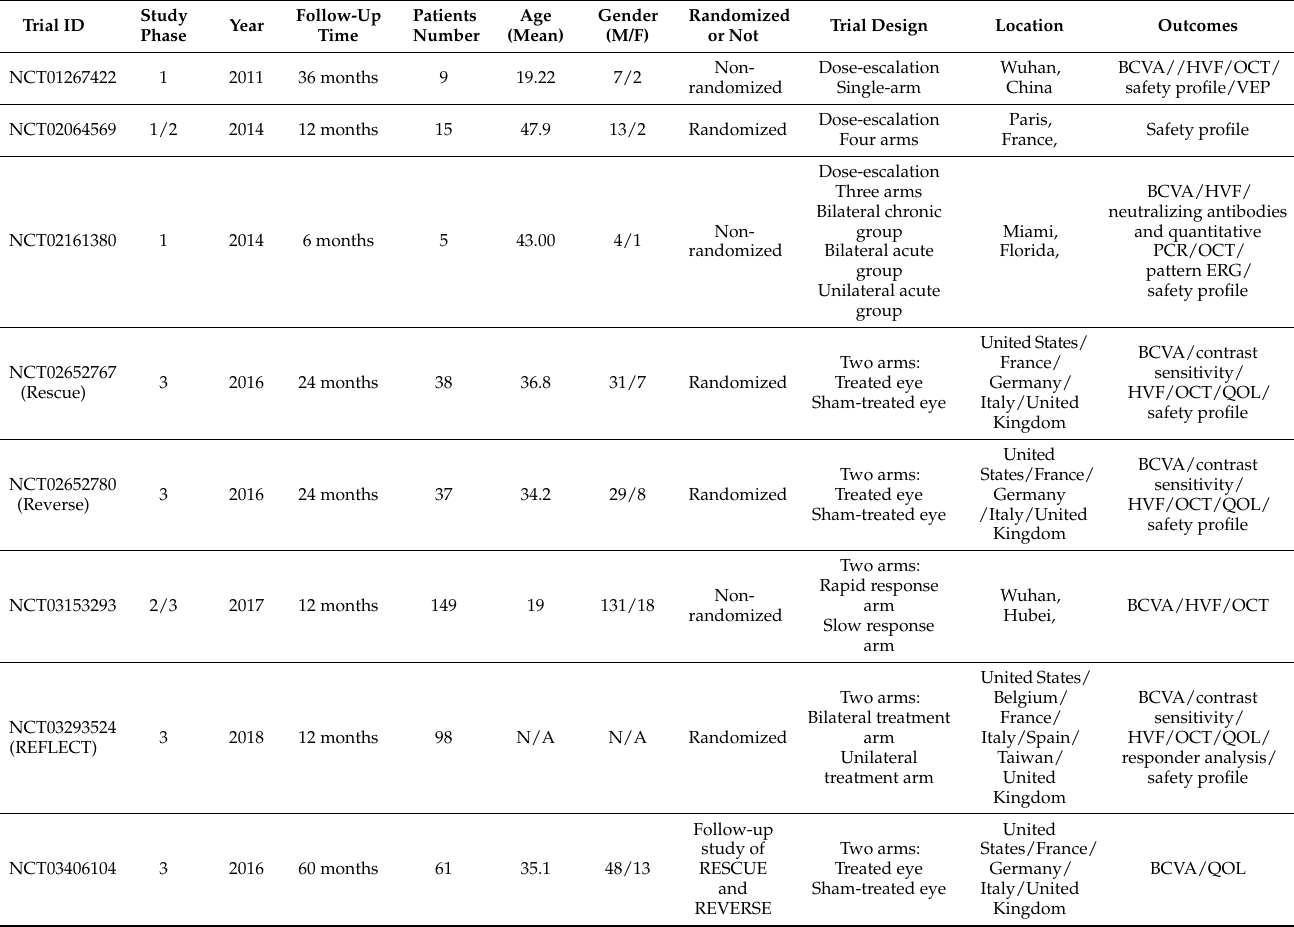
Table 1. Trial registration and characteristics of included